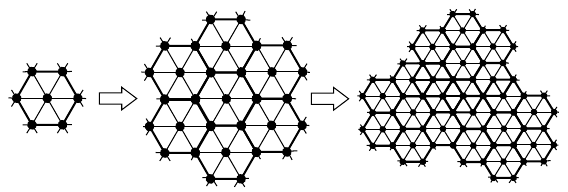
FIG. 1. A WRN cell can be concatenated many times to con- struct a large-scale network that is WR within some nodal boundary. Alternatively, outer edges can be looped in order to close the network so as to satisfy weak regularity everywhere (so there is no nodal boundary). In this example, k = 6 and there is only one unique adjacent-commonality multiset λ = { 2 } ∪ 6 (we employ a superscript union notation to describe the repeated union of a single set, e.g., { x } ∪ 3 = { x } ∪ { x } ∪ { x } = { x , x , x } ).